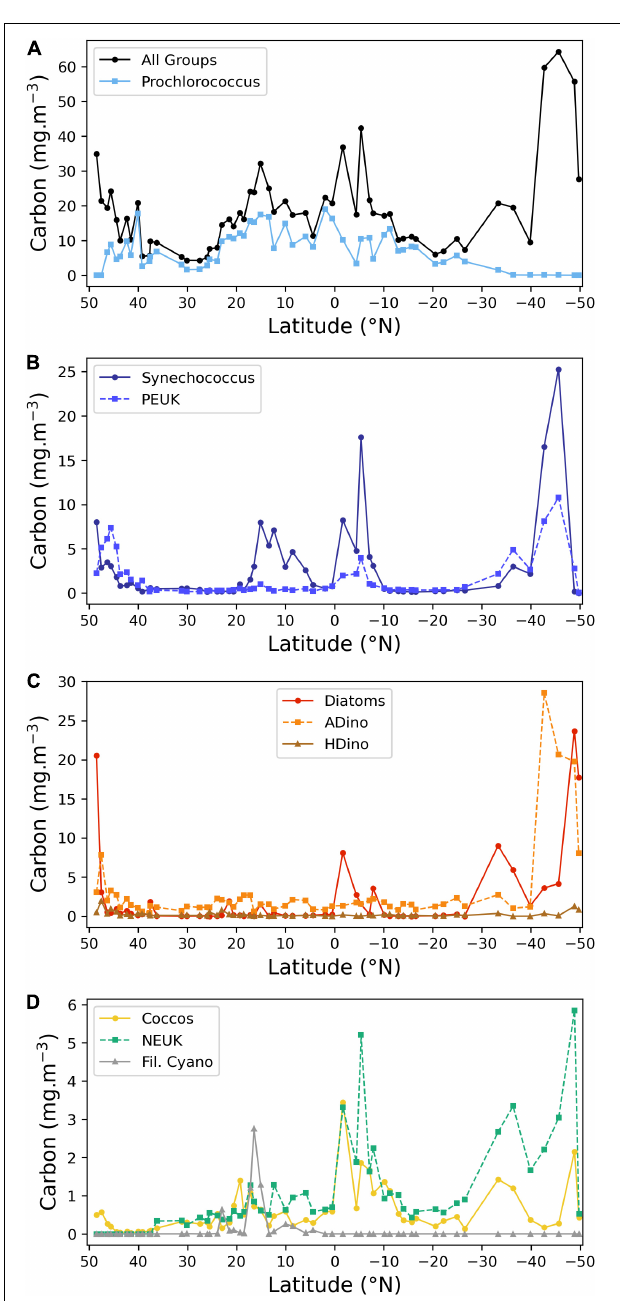
FIGURE 4 | Latitudinal distribution of the carbon biomass (mg carbon m − 3 ) of the main phytoplankton groups, determined by FC or microscopy. (A) Total carbon of all groups and Prochlorococcus spp.; (B) Synechococcus spp. and picoeukaryotes (PEUK); (C) autotrophic and heterotrophic dinoflagellates and diatoms; (D) coccolithophores, other nanoplankton and filamentous cyanobacteria. Note different scales on Y -axes.